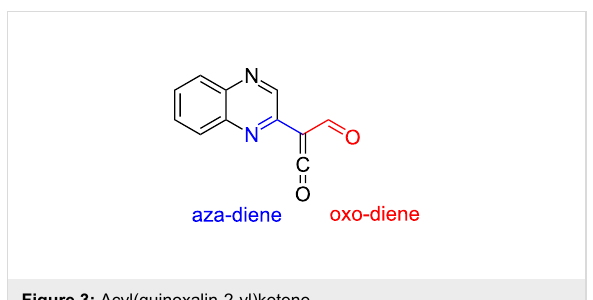
Figure 3: Acyl(quinoxalin-2-yl)ketene.